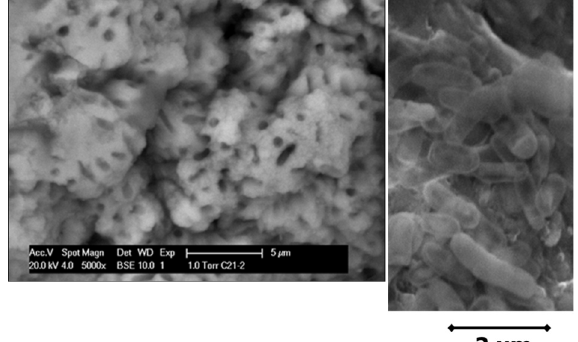
Figure 1. Environmental Scanning Electron Microscopic image of bacterial limestone (evidenced by bacterial imprints; left image) and light microscopic image of active (vegetative) alkali ‐ resistant bacteria of the genus Bacillus (right image). Courtesy Arjan Thijssen, TU Delft.